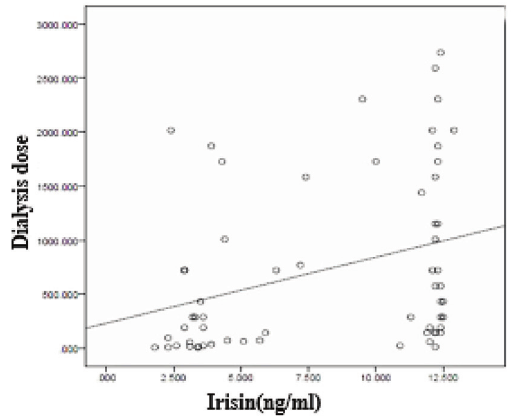
Figure 3. Positive and significant correlation between dialysis dose and irisin level ( P =0.01, r=0.32).